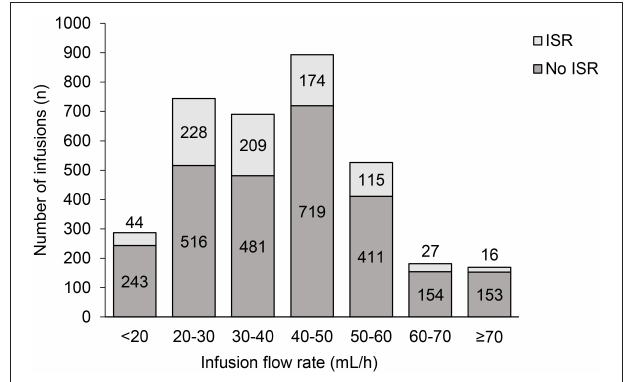
FIGURE 5 | Infusion flow rate and infusion site reactions. ISR, infusion site